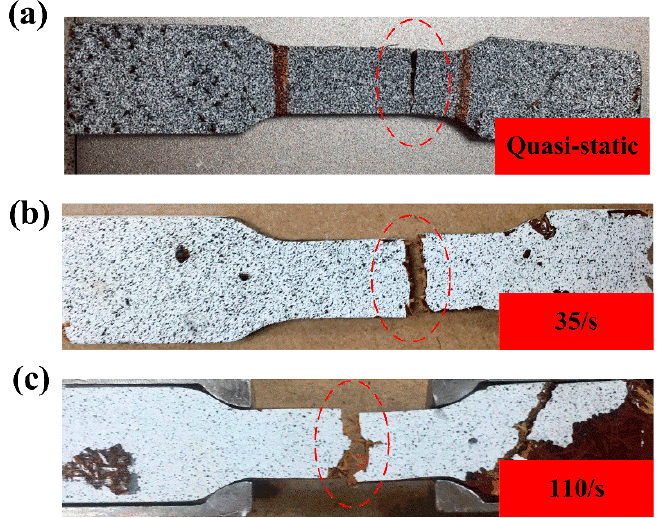
Figure 12. Fracture morphologies of the composite under different strain rates. ( a ) Quasi-static, ( b ) 35/s ( c ) 110/s.